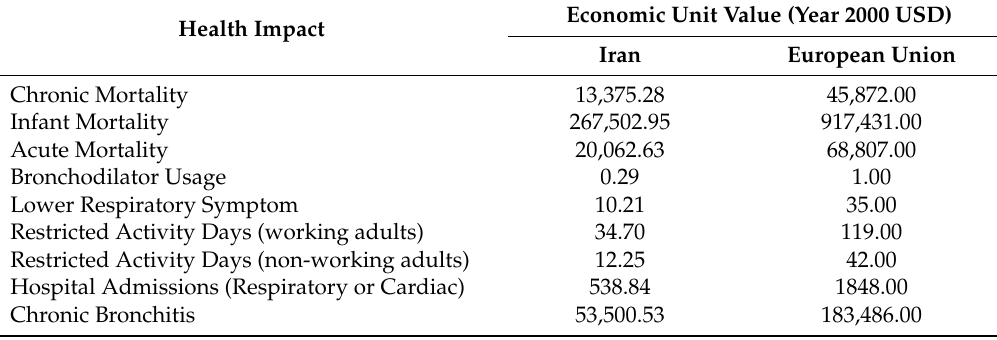
Table 2. Unit damage cost of the health impacts and their adjustments for Iran from EU values.